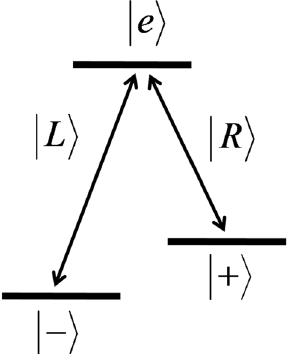
Figure 5. (cid:31) type optical transitions possible in a quantum dot. The transitions associated with the left and right polarization of the photon, denoted as